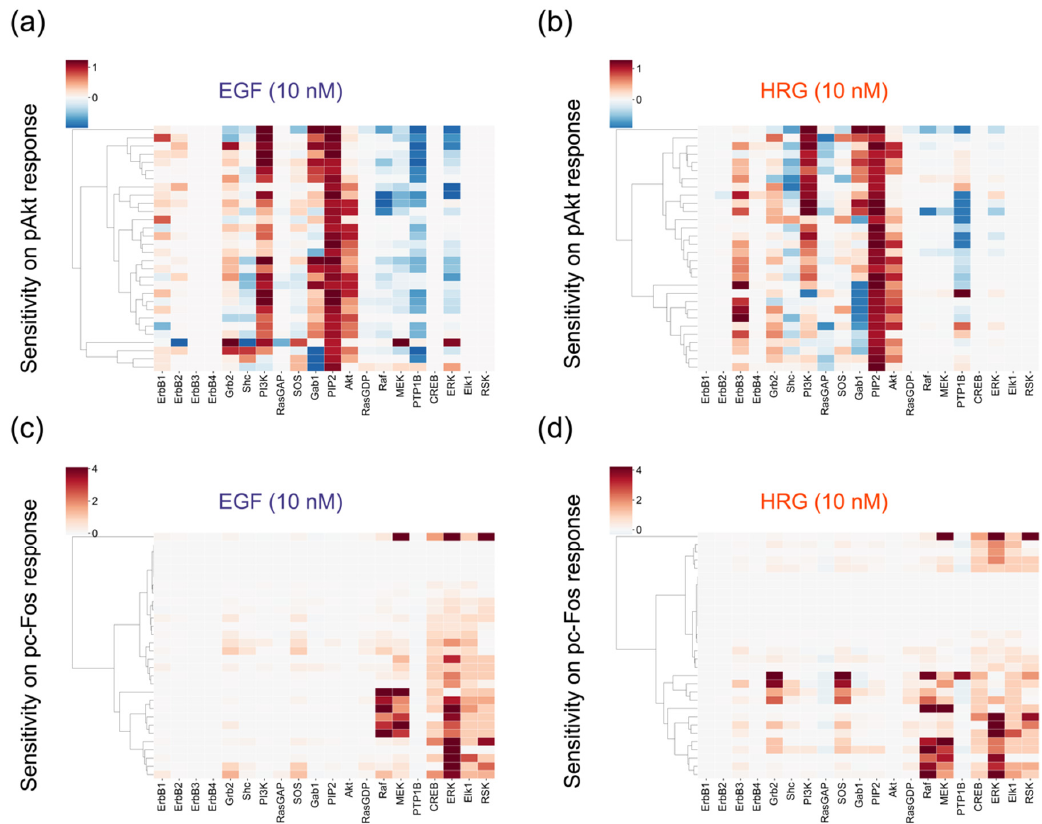
Figure 5. Results of sensitivity analysis. Negative coefficients (blue) indicate that the quantity of the response metric will decrease when the amount of a species increases, while positive coefficients (red) indicate that the metric will increase. ( a ) Epidermal growth factor (EGF)-induced pAkt response. ( b ) heregulin (HRG)-induced pAkt response. ( c ) EGF-induced pc-Fos response. ( d ) HRG-induced pc-Fos response.